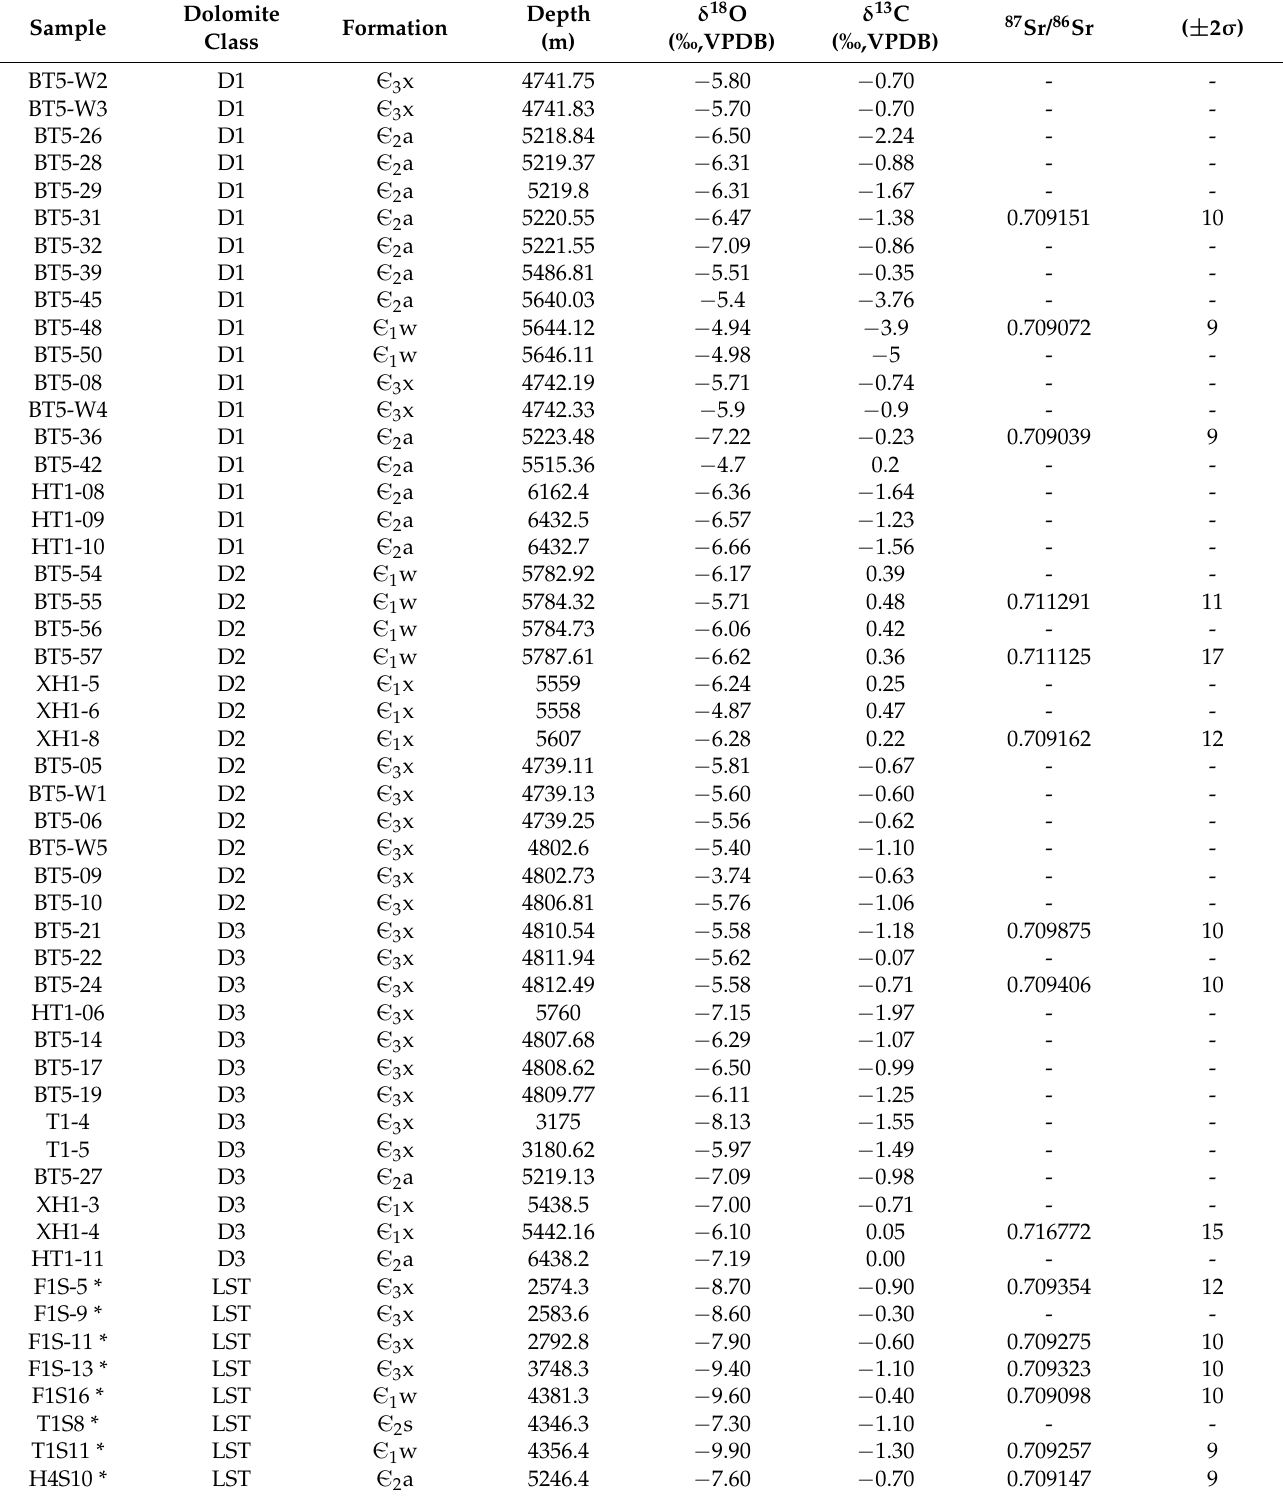
Table 2. Isotopic data ( δ 13 C, δ 18 O, and 87 Sr/ 86 Sr) of D1, D2, and D3 dolomites in the Bachu area, Tarim